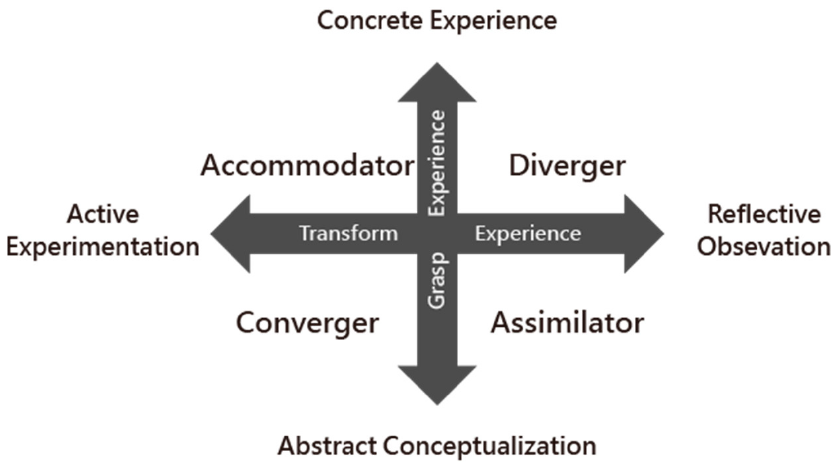
Figure 2. Kolb learning style model (redrawn for this study).